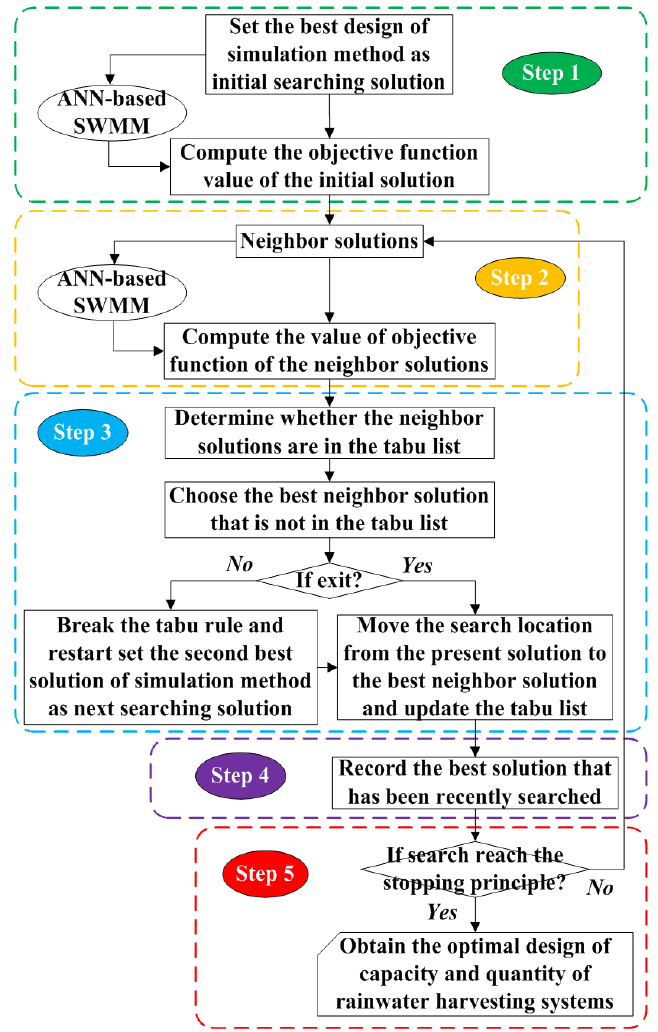
Figure 2. Flowchart of optimizing the spatial design of capacity and quantity of rainwater harvesting systems using tabu